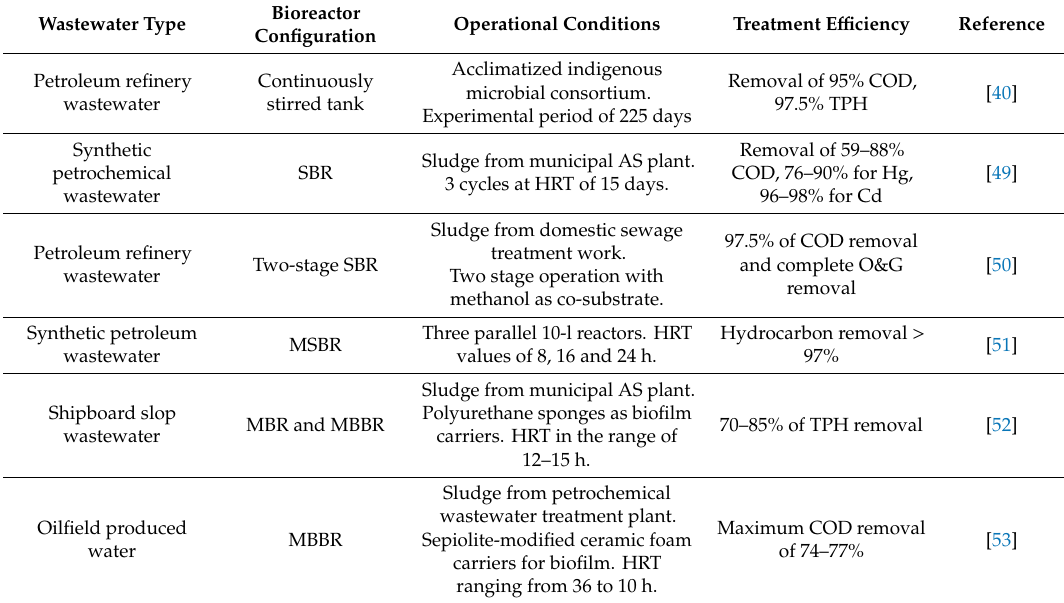
Table 2. Aerobic Bioreactors Used for Hydrocarbon-Containing Wastewater